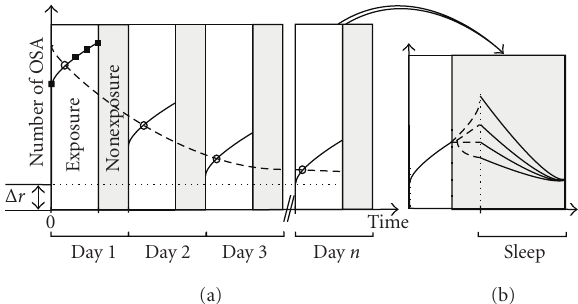
Figure 1: The dynamics of o ffl ine sequential activity (OSA) as a function of exposure. This schematic summarizes the results of many reactivation studies in novel and familiar environments. (a) The number of OSA within a day increases with the length of exposure (solid line segments). At the same time, the level of OSA decreases across days as the animal becomes familiar with a novel environment (dashed line). Δ r represents the amount of intrinsic OSA ( Δ r = 0 implies that OSA are purely reactivation of prior sensory-driven sequences). The grey-shaded regions are compressed, and the dynamics within these regions is omitted here for clarity. They are shown in the next panel. (b) Dynamics of OSA within one day. The solid lines are based on experimental observations. The dashed lines represent di ff erent hypotheses about the unknown dynamics of OSA between the end of the exposure and the beginning of the sleep